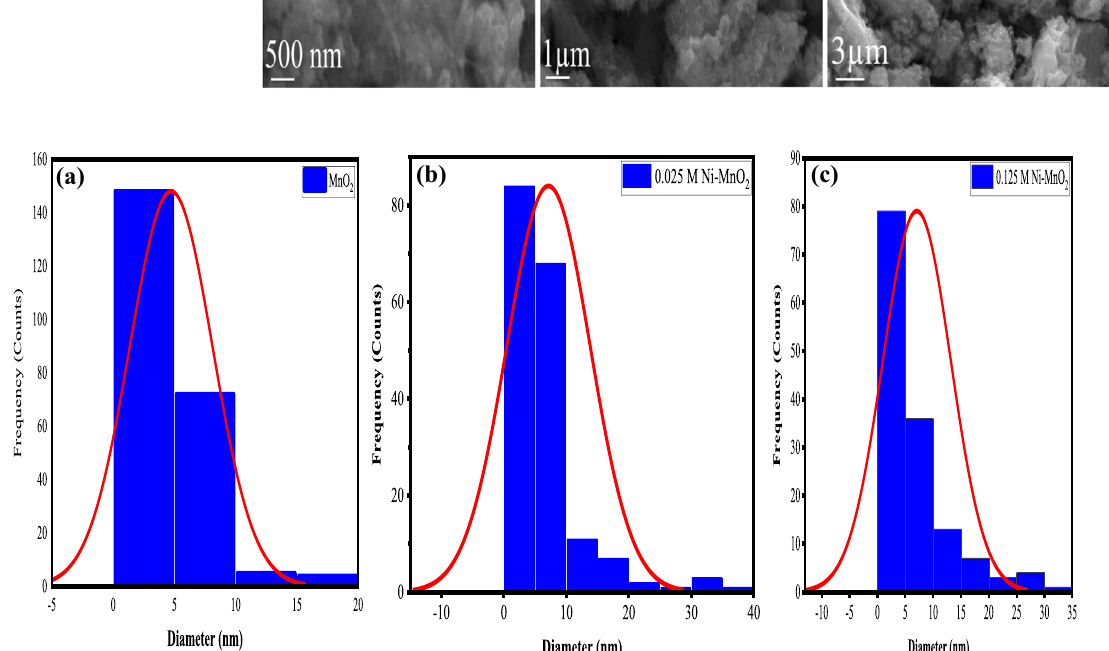
, b 0.025 M Ni-doped MnO 2